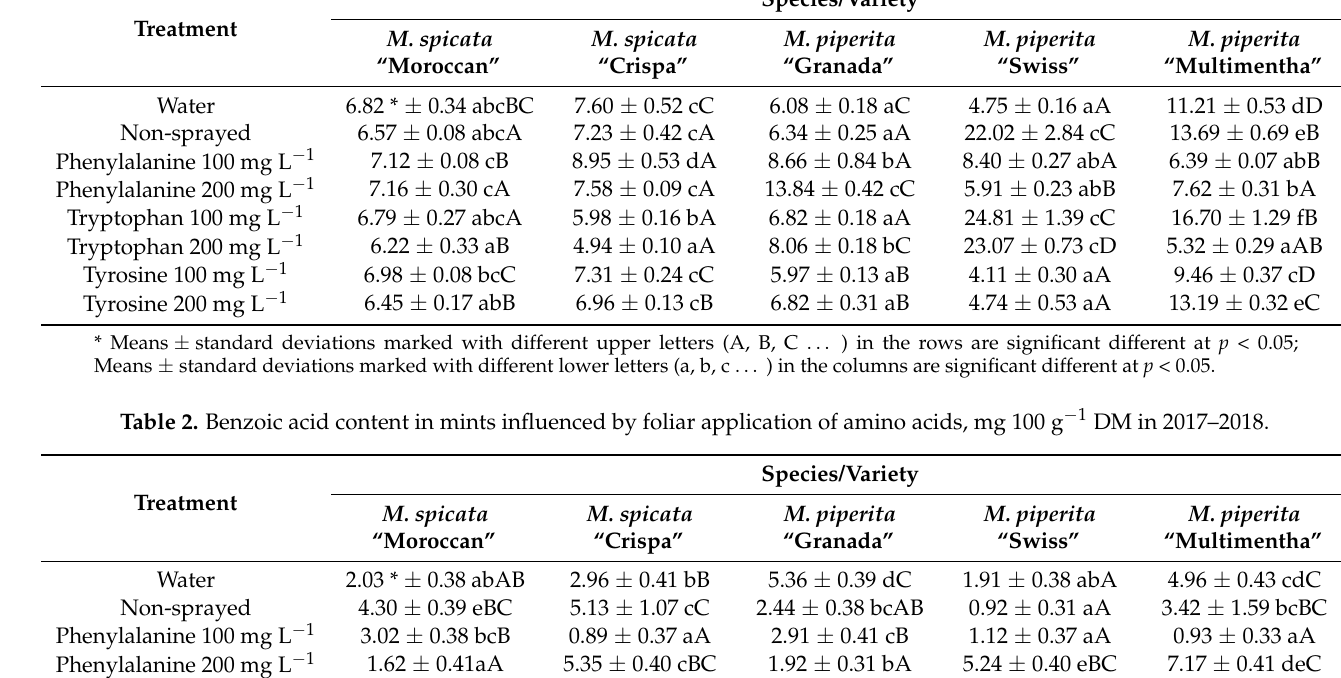
Species/Variety